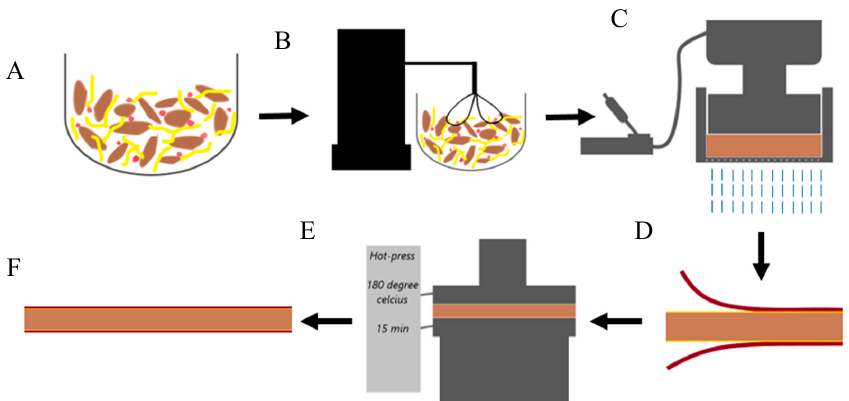
Figure 1. Schematic diagram of the panel formation process: ( A ) all components are placed in one container, ( B ) mixing wood particles, binder and additives, ( C ) contact dewatering via hydraulic pressure, ( D ) introducing two laminae of paper bonded to the core through a layer of CNF, ( E ) hot-pressing and ( F ) final